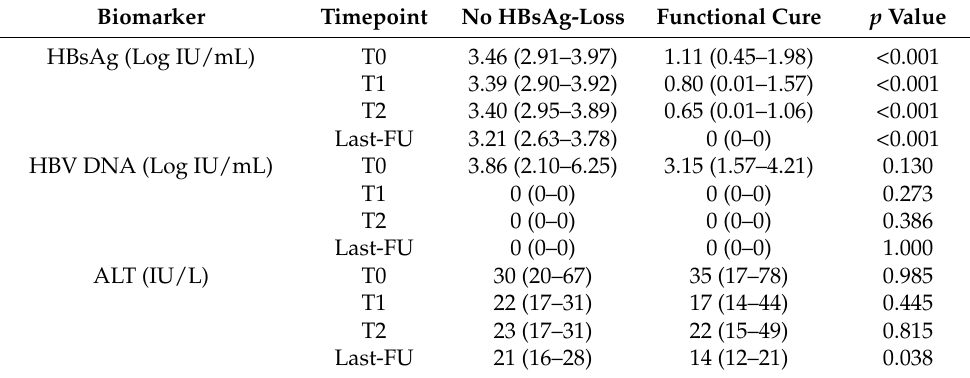
Table 2. Comparison of HBsAg, HBV DNA and ALT levels according to HBsAg loss.